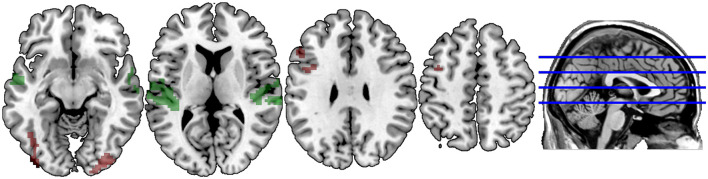
Spatial distribution of voxels demonstrating significantly greater lexicality effects in the Unimodal task (green) vs. the Crossmodal task, and demonstrating significantly greater lexicality effects in the Crossmodal task (red) vs. the Unimodal task. Clusters are extent-corrected at an FWE significance level of p < 0.05, with an uncorrected voxel-wise p < 0.001.